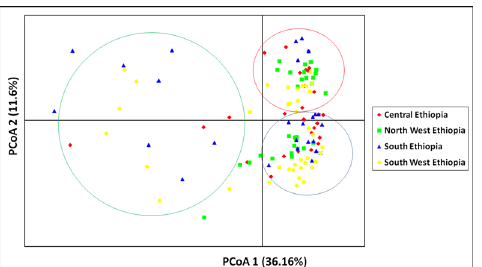
Fig 2. Principal coordinates analysis (PCoA) bi-plot showing the clustering of the 163 Colletotrichumgloeosporioides isolates based on 23 microsatellite loci. The four populations are color coded as follows: Central region ( red ), Northwest region ( green ), South region ( blue ) and Southwest region ( yellow ). Percentages of variation explained by the first 3 axes (1, 2, and 3) are 36.16%, 11.6% and 8.68%,